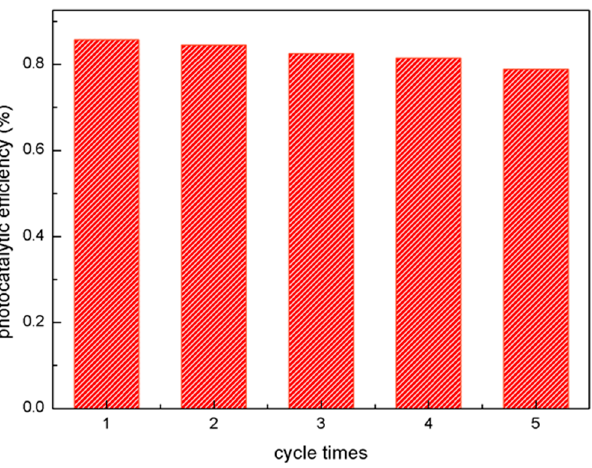
Figure 10. Cycling runs of the photocatalytic activity during the photocatalytic degradation of TC over 0.4Ni/Ti-Bi 2 WO 6 photocatalyst under visible-light irradiation.